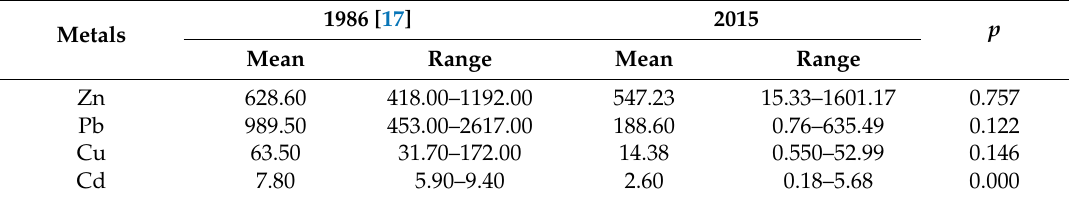
Table 2. Available concentrations of topsoil (0–20 cm) metals in 1986 and 2015 (mg/kg).